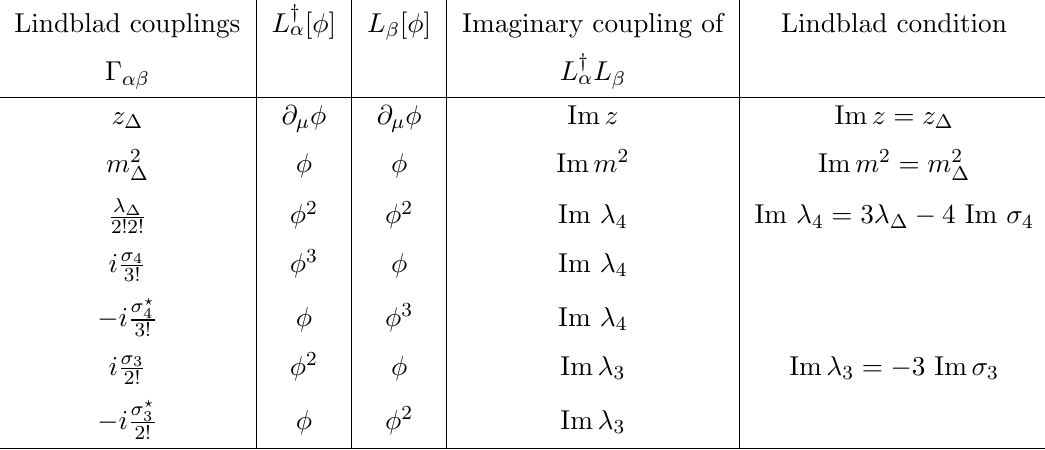
Table 1. Renormalisable Lindblad operators for (cid:30) 3 + (cid:30) 4 theory.